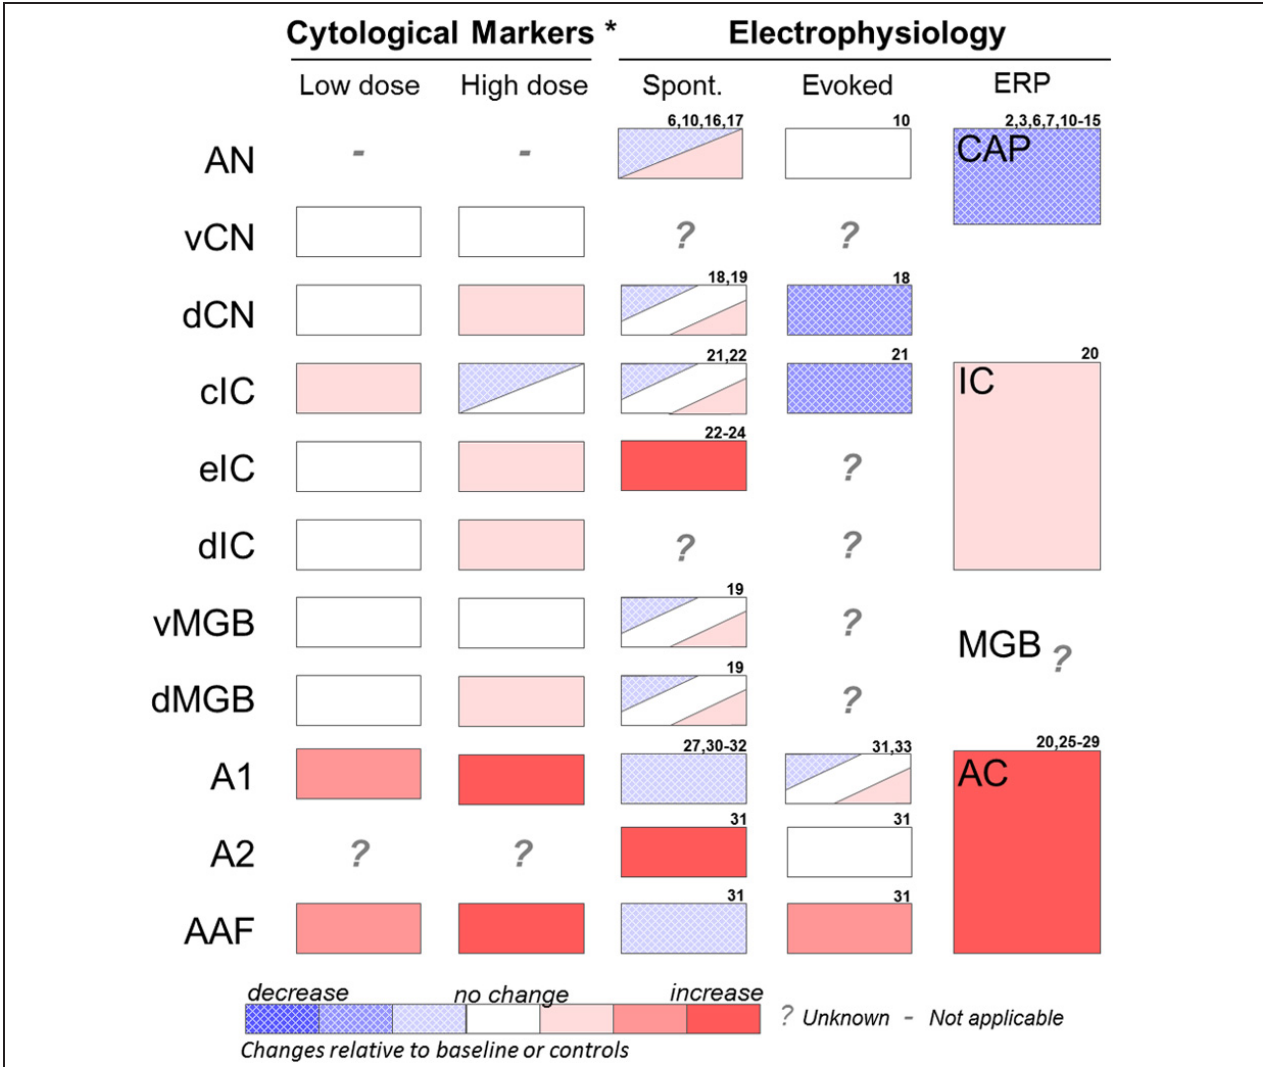
FIGURE 2 | Summary of effects of salicylate on various auditory structures. Cytological studies include results from 2-DG and fos-IR imaging studies (see Section “Identifying Key Brain Regions”) and were performed at low (50mg/kg i.p.) or high (350mg/kg i.p.) acute doses of salicylate. Electrophysiology recordings were performed at various moderate to high salicylate doses. Results are from studies using in vivo extracellular recordings or in vitro extracellular or patch clamp recordings (see Section “Electrophysiology”). AN, auditory nerve; vCN, ventral cochlear nucleus; dCN, dorsal cochlear nucleus; cIC, central nucleus of the inferior colliculus; eIC, external nucleus of the inferior colliculus; dIC, dorsal nucleus of the inferior colliculus; vMGB, ventral portion of the medial geniculate body; dMGB, dorsal portion of the medial geniculate body; A1, primary auditory cortex; A2, secondary auditory cortex; AAF, anterior auditory field. Spont, single unit or multiunit spontaneous firing rates; Evoked, sound-evoked single unit or multiunit firing rates; ERP, sound-evoked response field potential;